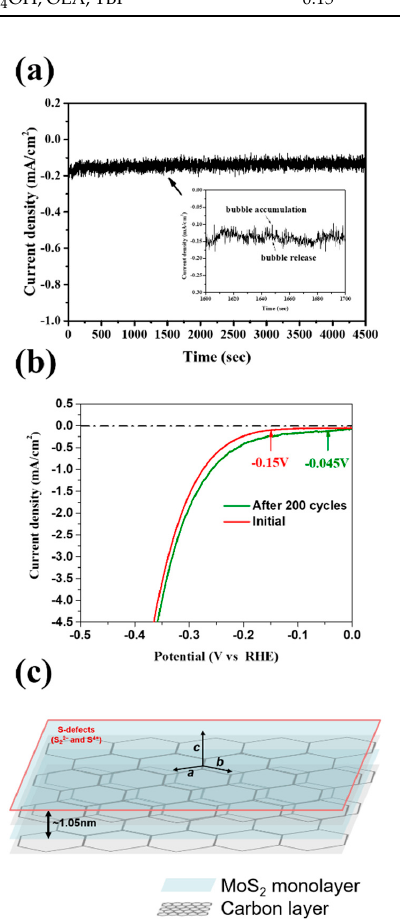
Figure 7. ( a ) Chronoamperometric (j-t) response of the MoS 2 -carbon electrocatalyst for 4500 s at − 0.2 V (vs. reversible hydrogen electrode, RHE) which is slightly higher than the onset potential. The inset shows an enlarged image to highlight the bubble accumulation and release. ( b ) LSV testing of the MoS 2 -carbon electrocatalyst for 200 cycles. ( c ) Schematic of the MoS 2 -carbon inter-overlapped superstructure